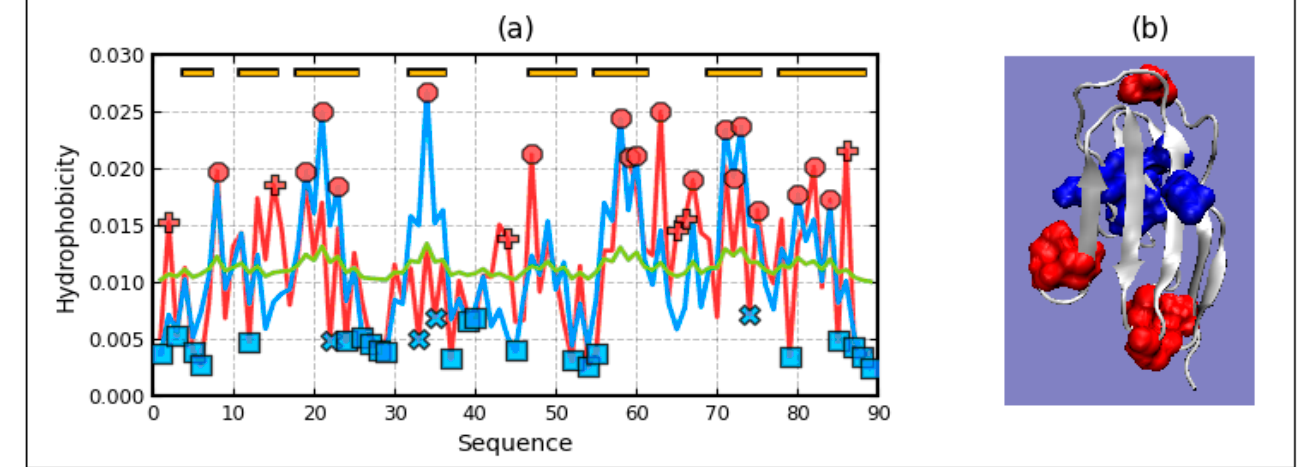
Figure 15. Hydrophobicity distribution in titin. ( a ) T (blue), O (red), and M (green) as appear in titin. The blue squares— residues on the surface representing low hydrophobicity—status accordant with FOD criteria. ( b ) 3D structure of titin with residues of local hydrophobicity deficiency (“X” on the profiles in ( a )) and local hydrophobicity excess (“+” on the profiles in ( a ))—red.